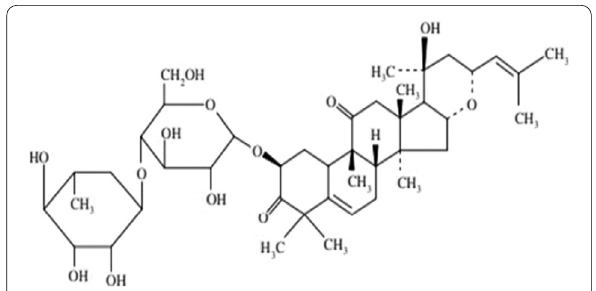
Fig. 2 22-deoxocucurbitosides